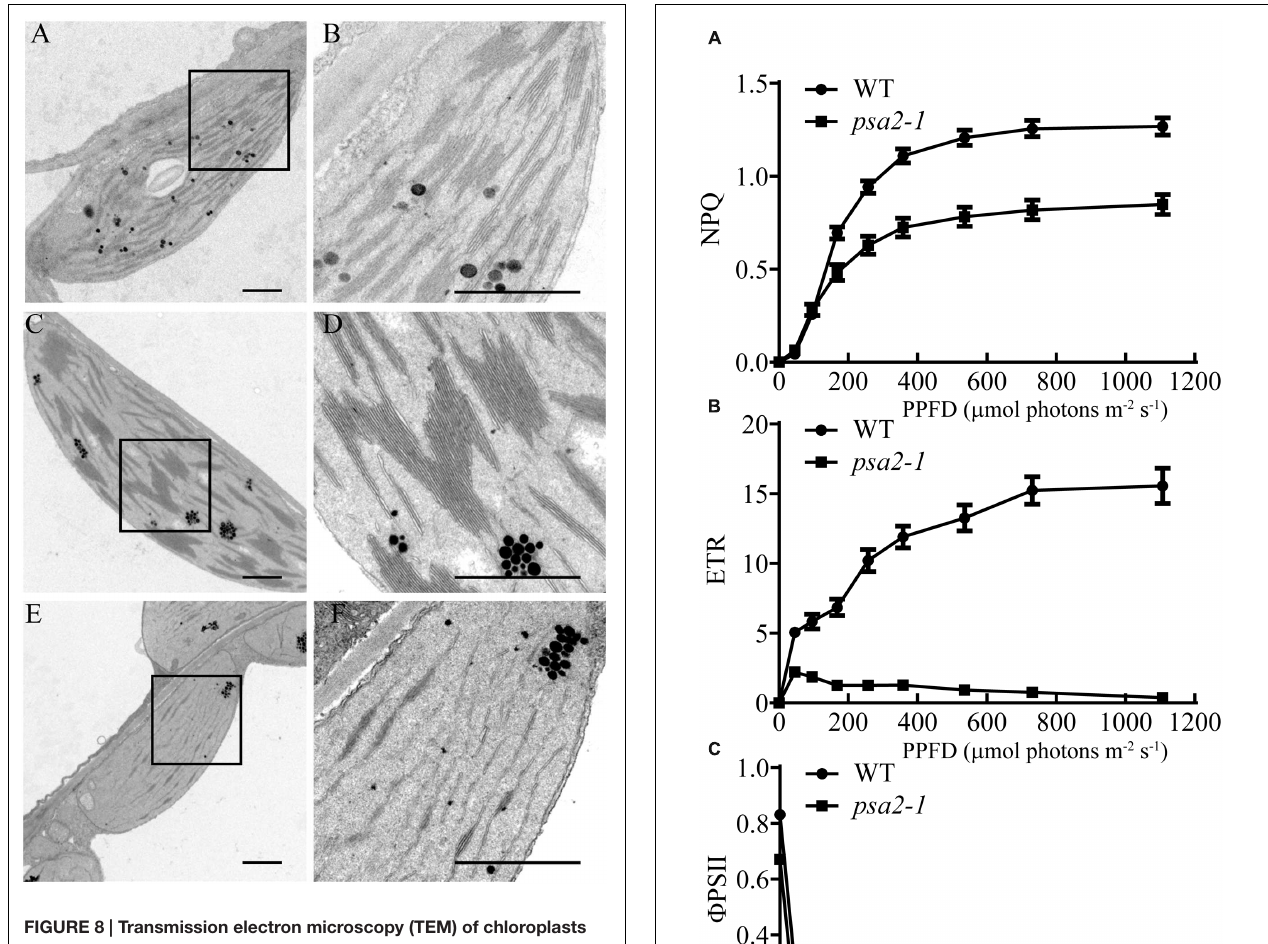
FIGURE 8 | Transmission electron microscopy (TEM) of chloroplasts from leaves of the wild-type plants (A,B), and from the green (C,D) and pale yellow (E,F) regions of the variegated leaves of the psa2-1 seedlings. Bar = 1 µ m. (B,D,F) are magnified view of the boxed regions in (A,C,E) , respectively.